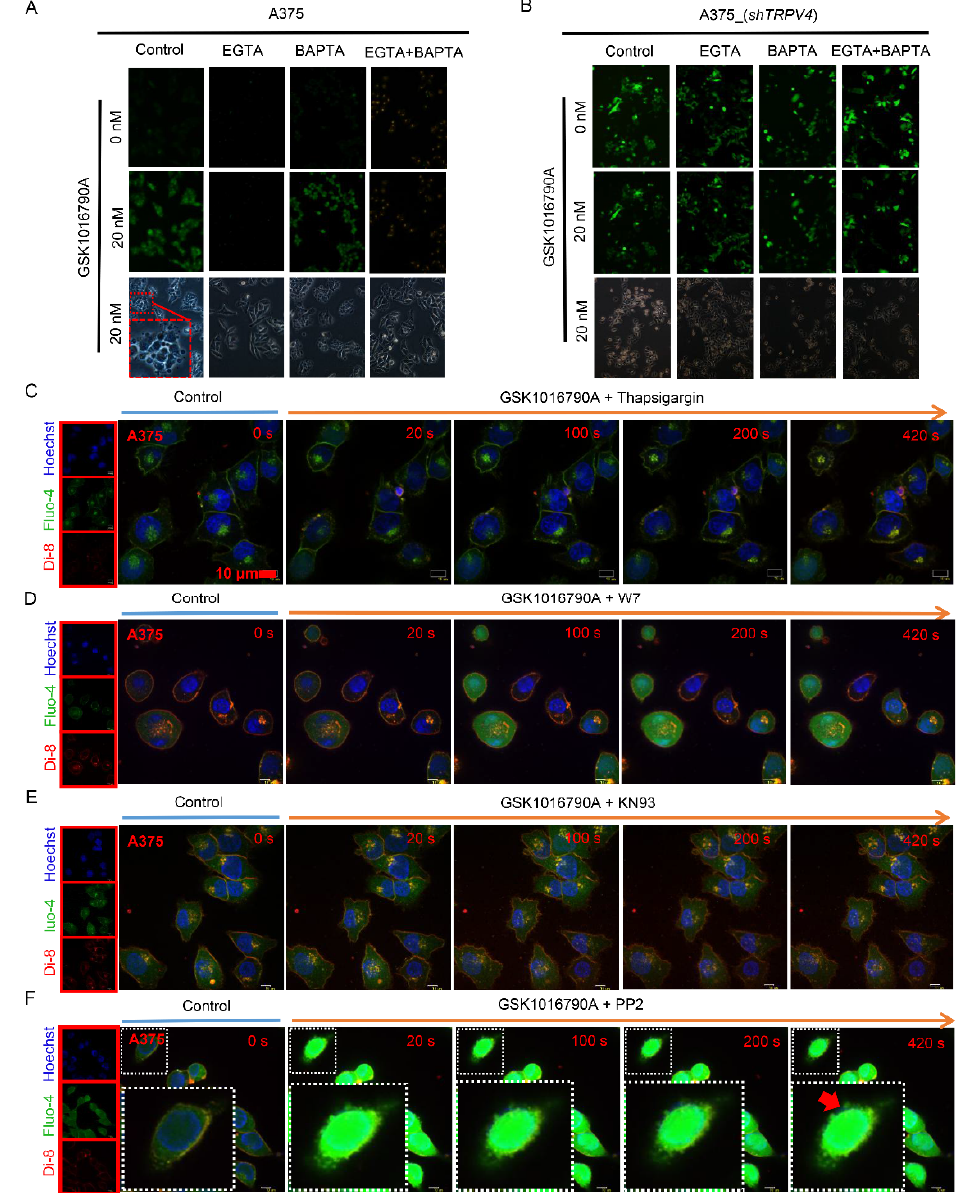
Figure 3. Blockade of Ca 2+ signaling mediates exocytosis during activation of TRPV4 ion channel. ( A ) Cell images of A375 cells in GSK1016790A (20 nM) application with pretreatment by EGTA (0.5 mM) or BAPTA, AM (8 µ M). ( B ) A375 cells in shTRPV4 upon agonist stimuli with blockade of either extracellular or intracellular calcium. ( C ) Time-lapse of scanning disk confocal images of A375 cells upon GSK1016790A (20 nM) stimuli with pretreatment with thapsigargin (50 nM). ( D ) Time-lapse of scanning disk confocal images of GSK1016790A (20 nM) application to A375 cells with pretreatment with W7 (10 µ M), a calmodulin antagonist. Scale bar, 10 µ m. ( E ) Time-lapse of scanning disk confocal images of GSK1016790A (20 nM) application to A375 cells with pretreatment with KN93 (1 µ M), a selective inhibitor of Ca 2+ /calmodulin-dependent kinase II. Scale bar, 10 µ m. ( F ) Scanning disk confocal images for time-lapse in A375 cells upon GSK1016790A (20 nM) addition with pretreatment of PP2 (10 µ M), an effective inhibitor of tyrosine kinases. Scale bar, 10 µ m. 2.4. Accumulation of Lysosome-Associated Proteins Facilitated TRPV4-Mediated